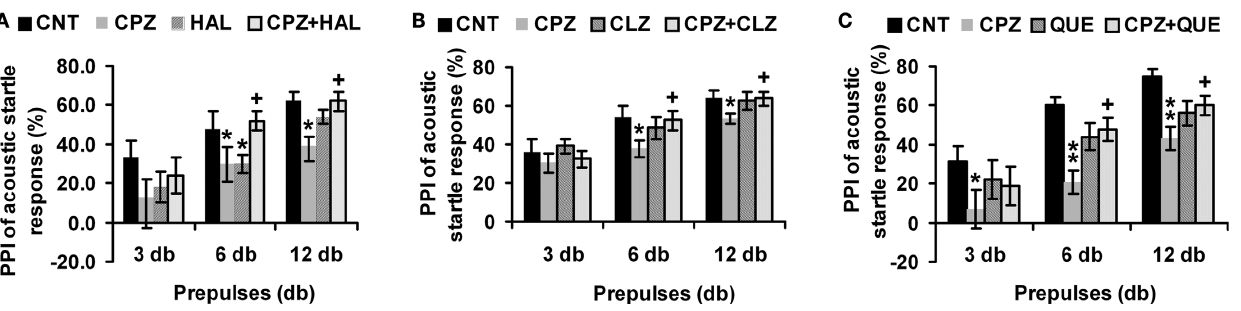
FIGURE 1 | Effects of antipsychotics on the CPZ-induced defi cits in PPI test. Control and experimentally treated C57BL/6 mice were subjected to PPI test on the same day (14th day after CPZ-exposure). (A) The data of the HAL experiment. (B) The data of the CLZ experiment. (C) The data of the QUE experiment. Data were expressed as M ± SEM ( n = 6 to 12/group). CNT, Control group; CPZ,